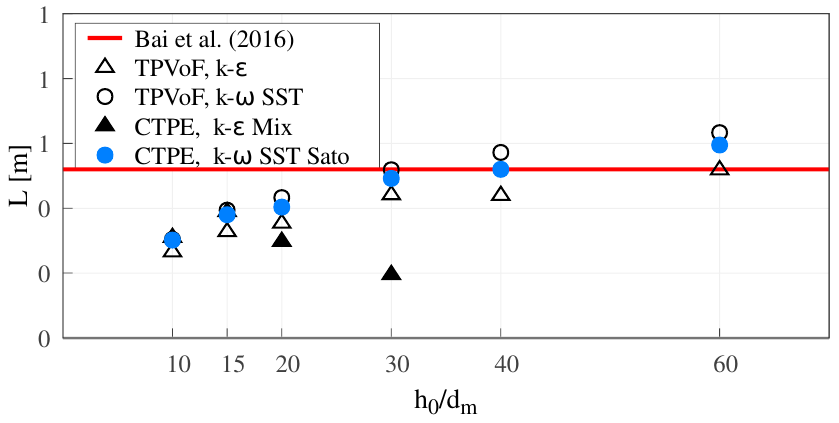
Figure 10. Cavity zone length ( L ).